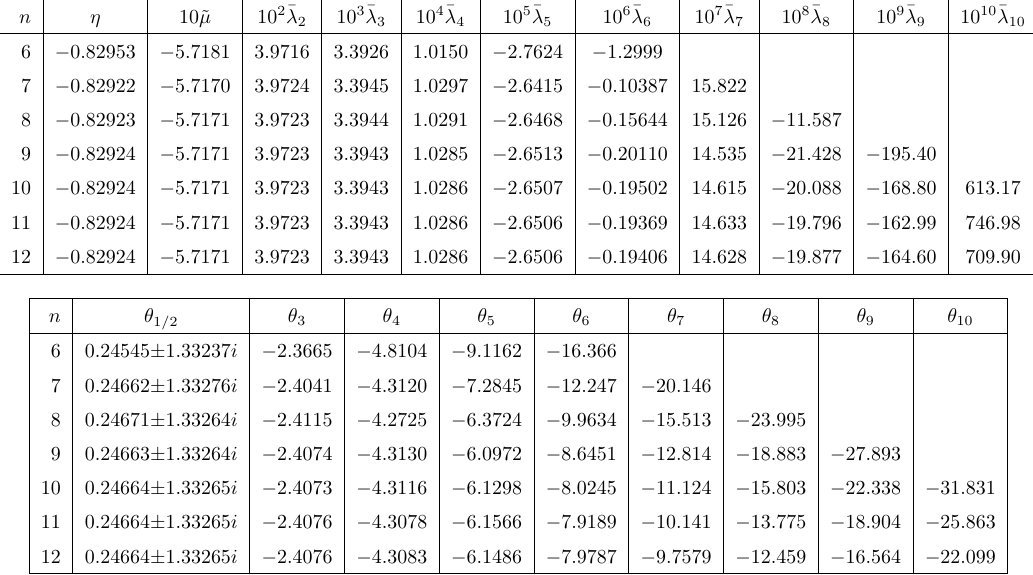
Table 4 . Values of the coupling constants and scaling exponents at the NGFP 2 in the large- N k regime for r = d r + 1 = 4 and ζ = 1 / 2 in the ( ¯ ϕϕ ) n truncation of the LPA 0